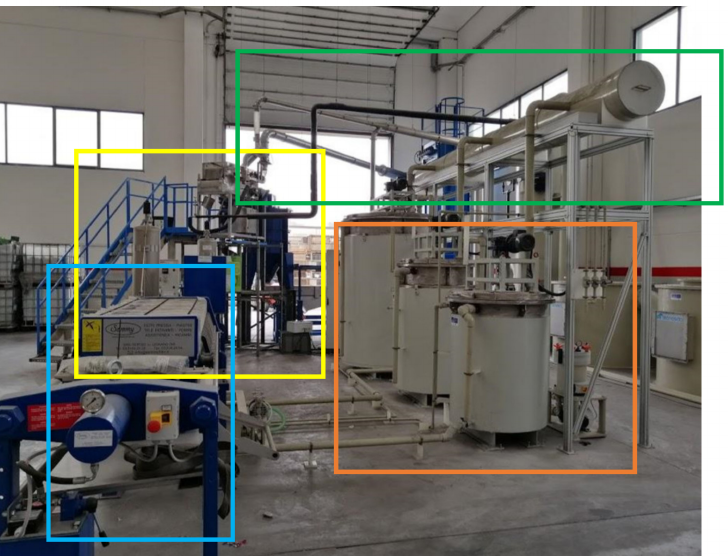
Figure 2. LIBAT prototypes at the SEVal site: cryo-mechanical section (yellow), sieving and separation of solid fraction (blue), hydrometallurgical section (orange), gas treatment section